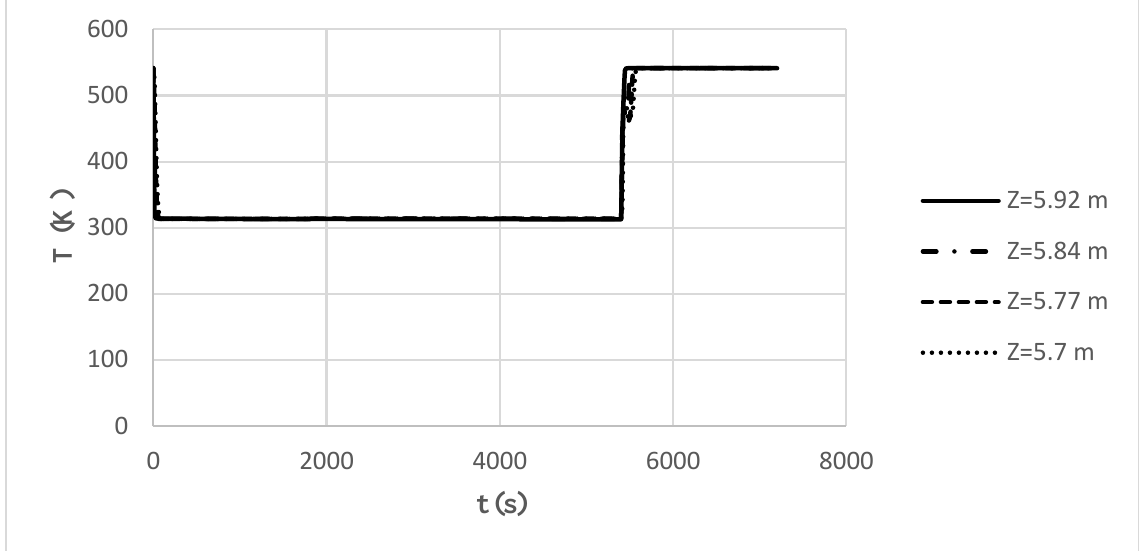
Figure 10. Temperature variation of the bed in the first layer with time.